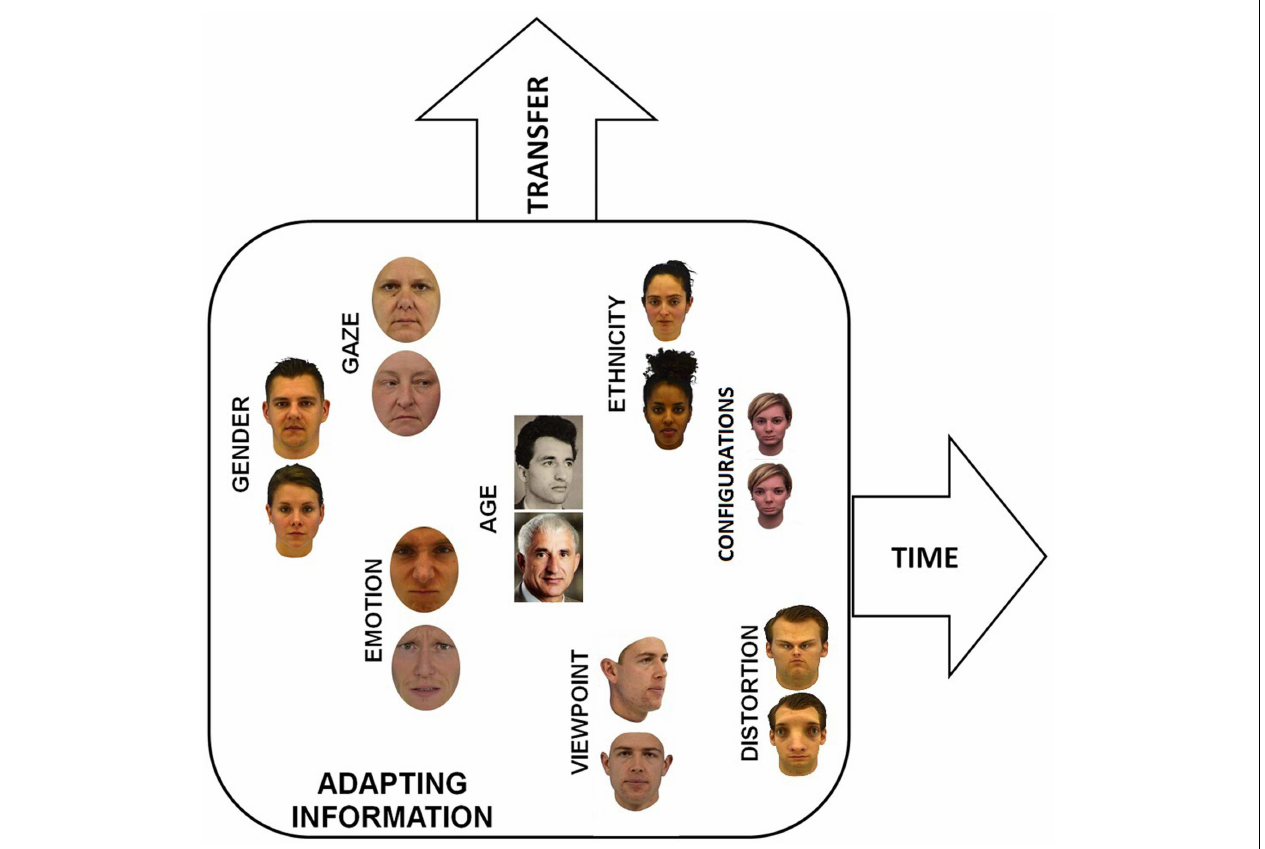
FIGURE 1 | Framework to review face adaptation effects including dimensions for different types of adapting information, transfer effects, and timing between adaptation and adaptation test phases .